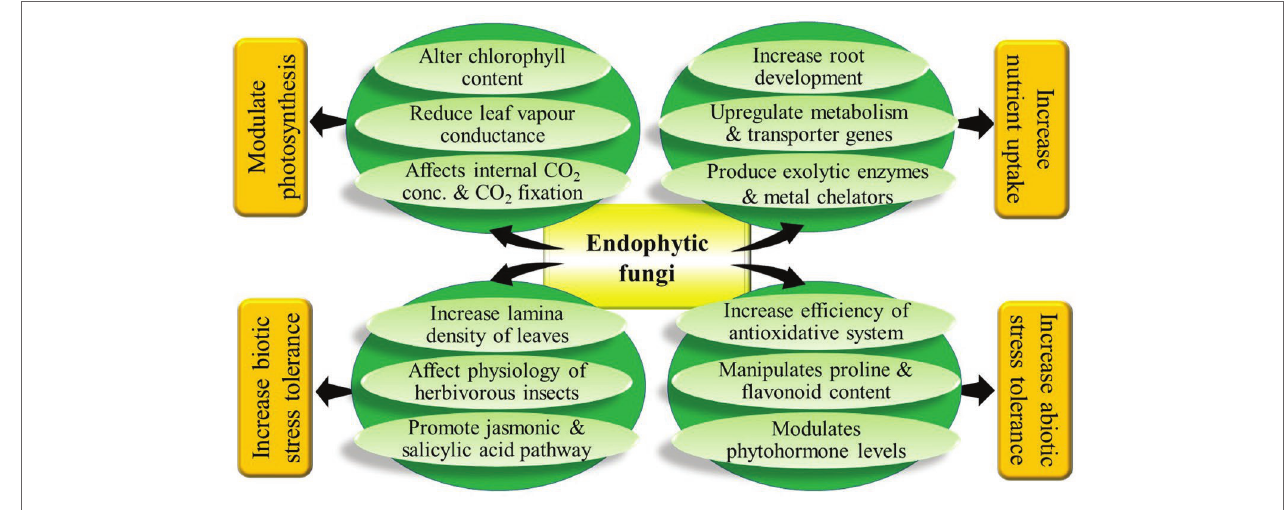
FIGURE 2 | Graphical